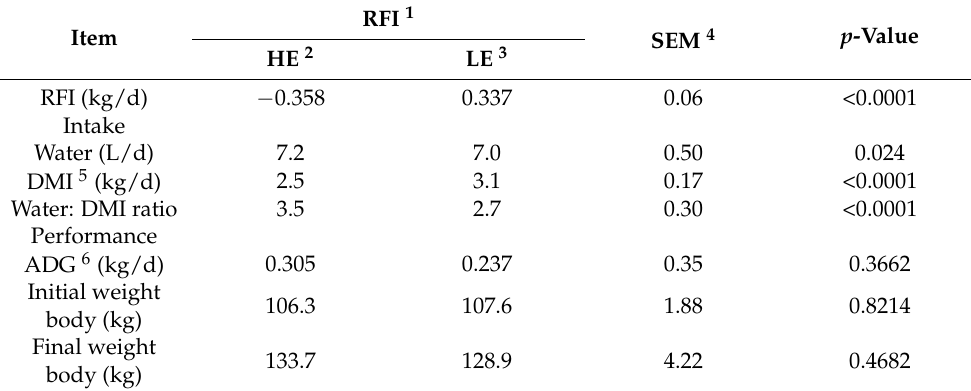
Table 2. Means of the indexes, intakes, and performances evaluated for HE and LE in residual feed intake (RFI); standard error of the mean (SEM) and group interaction (high efficiency: HE or low efficiency: LE) in dairy heifers phenotypically classified for